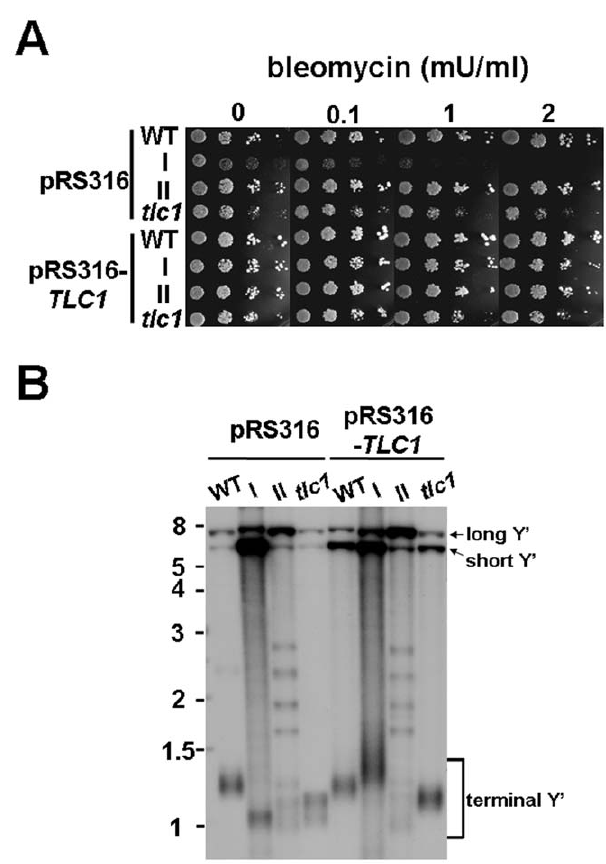
Figure 2. A CEN-based plasmid containing TLC1 complemented the sensitive phenotype of type I survivors. ( A ) Wild-type, pre- senescent tlc1 mutant, type I or type II strains carrying pRS316 or pRS316- TLC1 plasmid were five-fold serially diluted and spotted onto YEPD plates containing bleomycin in various concentrations. ( B ) Southern blot analysis of the Xho I-digested genomic DNA isolated from strains described in panel A probed to detect telomeric sequences.